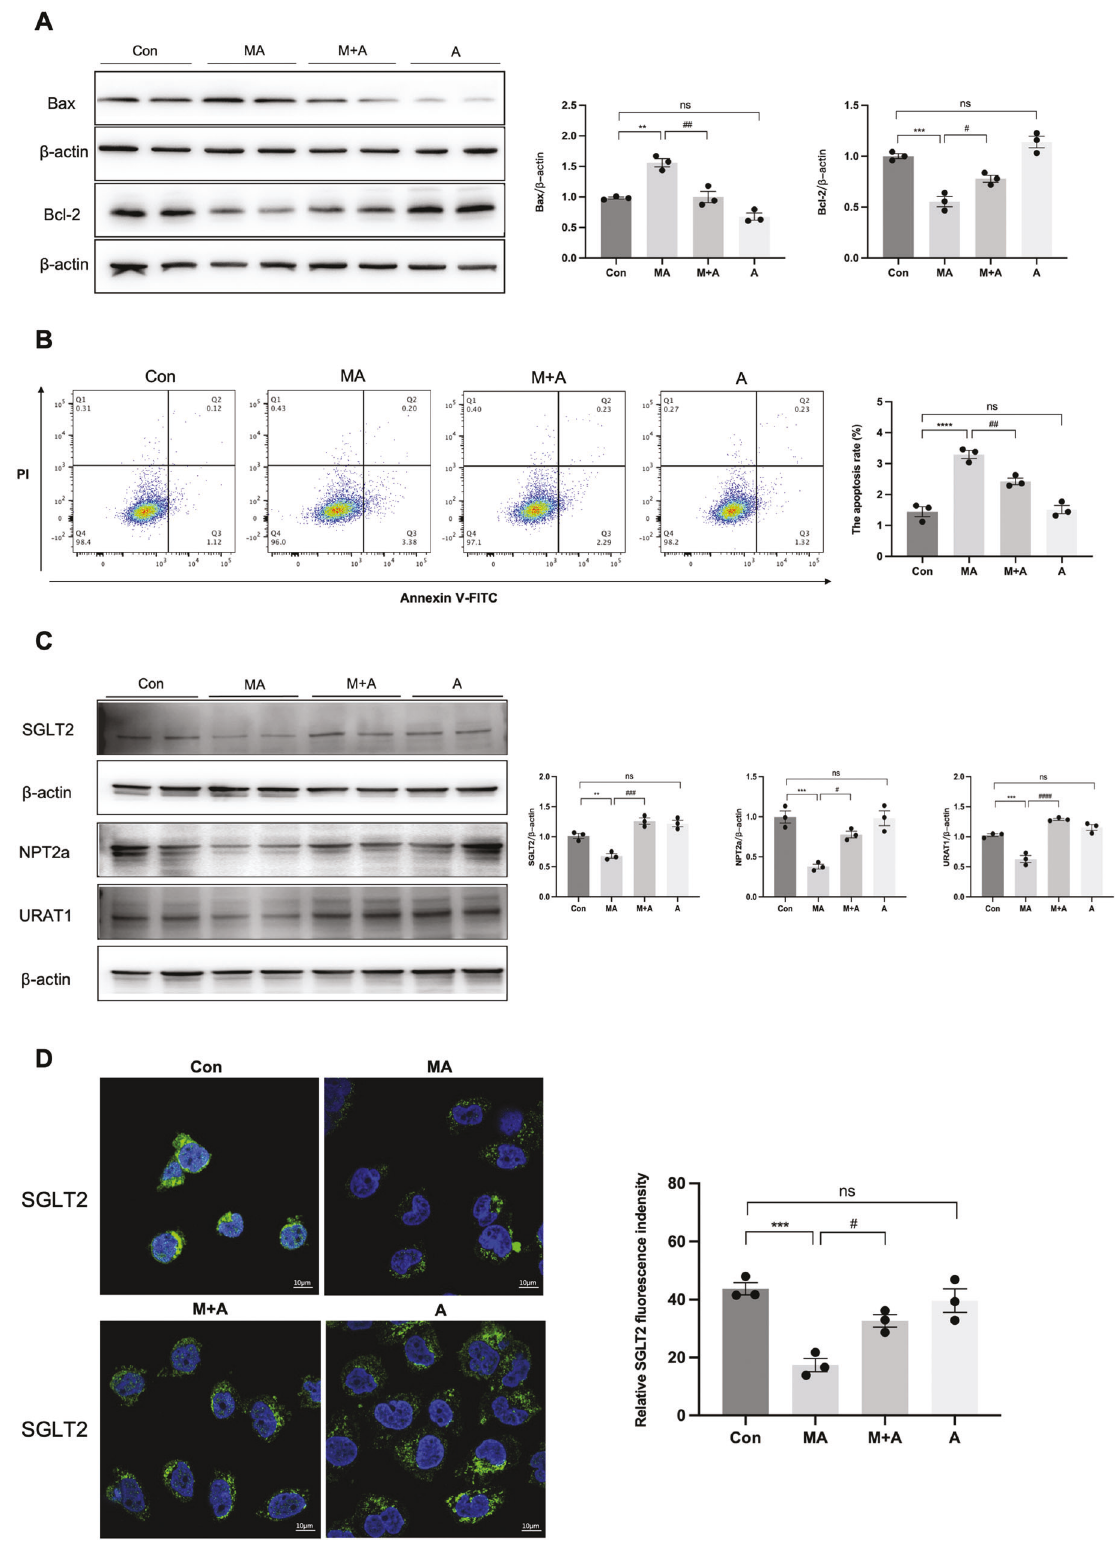
Fig. 6 ALDH2 activation inhibited apoptosis and tubular transporter disorder in HK-2 cells. A The expression of apoptosis-related proteins (Bax and Bcl-2) was measured by western blotting ( n = 3). B Apoptosis was determined by fl ow cytometry in 4 groups ( n = 3). C , D The expression of tubular transporter proteins (SGLT2, NPT2a and URAT1) was measured by western blotting ( n = 3) and immuno fl uorescence ( n = 3). Scale bars, 10 μ m. * P < 0.05, ** P < 0.01, *** P < 0.001, **** P < 0.0001; # P < 0.05, ## P < 0.01, ### P < 0.001, #### P < 0.0001; ns not signi fi cant. (Con Control, MA maleic acid, M + A maleic acid + Alda-1, A Alda-1).